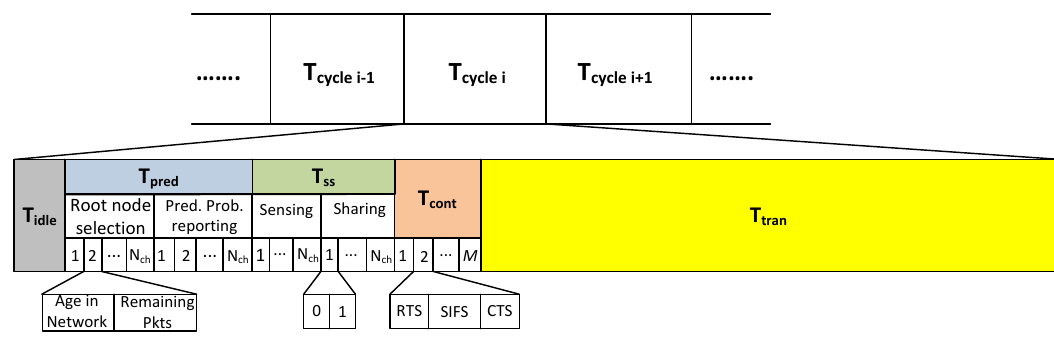
Figure 3. Proposed frame